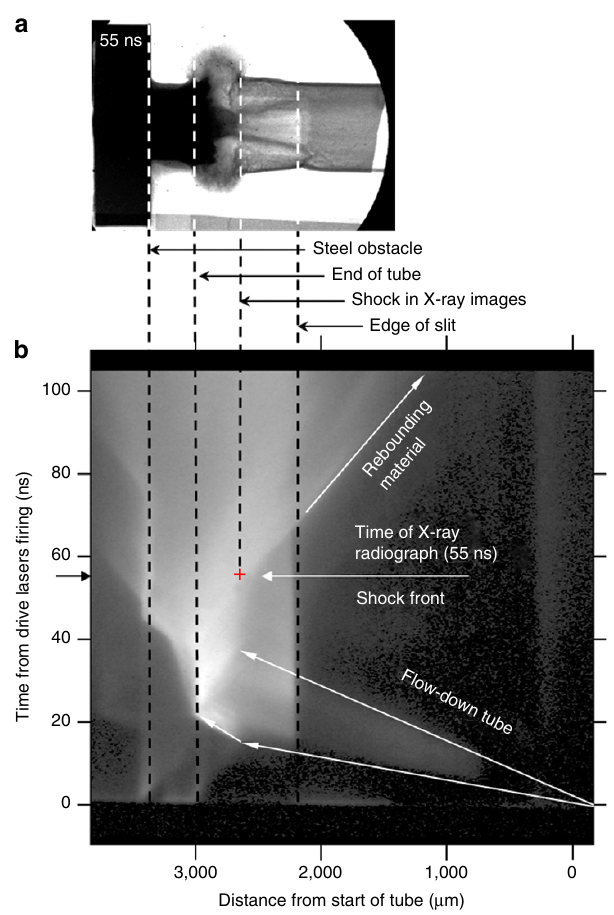
Figure 3 | Streaked optical image of the flow and shock evolution. ( a ) An X-ray image taken from Fig. 2 aligned with the streaked optical image in ( b ). Optical diagnostics were fielded in the experiment to record the self-emission from the hot plasma along the entire length of the tube. An imaging system directed the light emitted by the interacting plasma to the streak camera. The streak camera had a spatial field of view of B 4mm and thus the entire tube and obstacle were visible, except the region shielded by the copper cone. An imaging line aligned with the central axis of the tube (along the slit cut-out in the tube), in the horizontal plane, was then streaked in time over B 60, 100 or 250ns as required. This provided a temporal dependence of flow velocities in plasma. Time runs from bottom to top, distance right to left. The time evolution of the plasma can clearly be seen inside the tube. The dotted lines and overlaid radiograph show positions of parts of the target on the streaked image. There is good agreement in the position of features between the X-ray ( a ) and optical ( b )